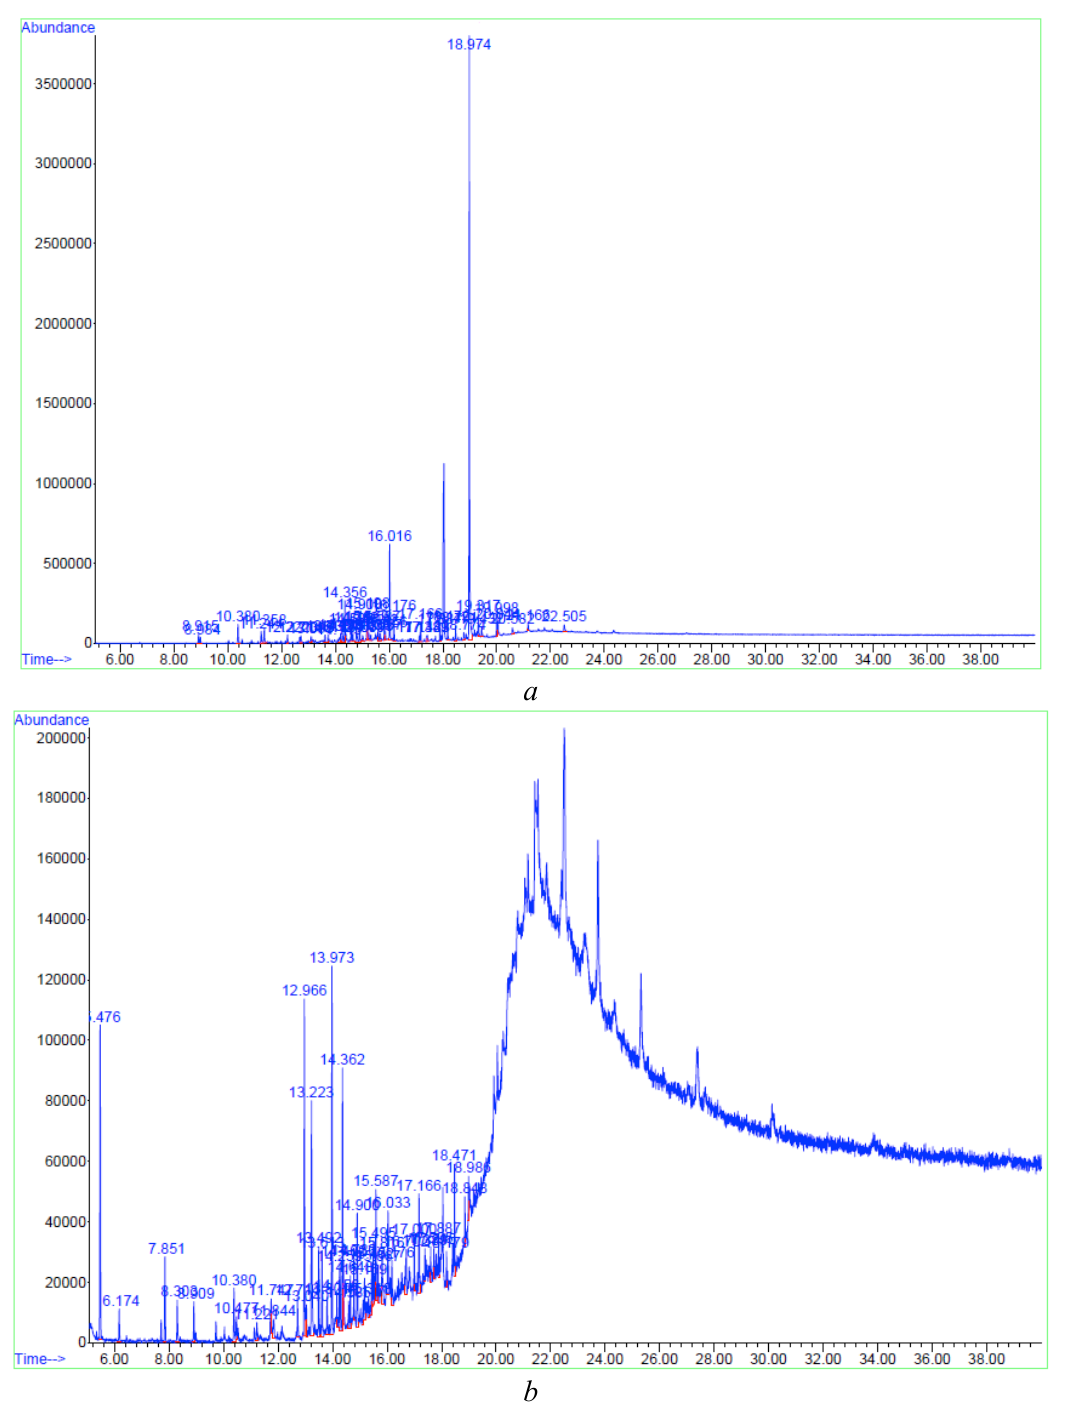
Fig. S2: GS-MS chromatogram of leaves ( a ) and fruits ( b ) of essential oil of F. viridis Weston from sample II